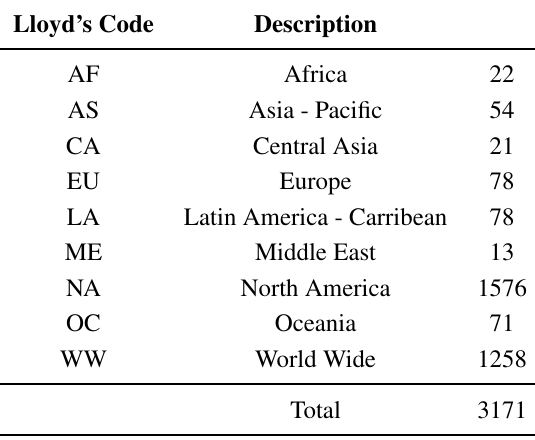
Table 4. Claim counts and regional